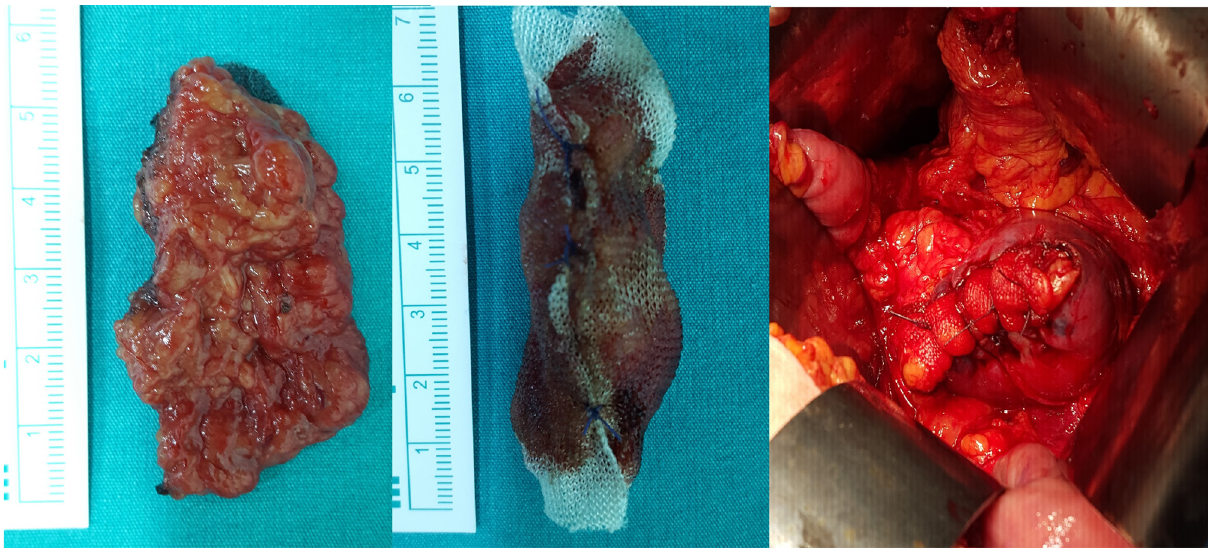
Figure 1: Perirenal adipose tissue taken from the non-tumoral area (left); appearance after the Surgicel is wrapped around the adipose tissue (middle); Surgicel-wrapped adipose tissue that was used for defect repair